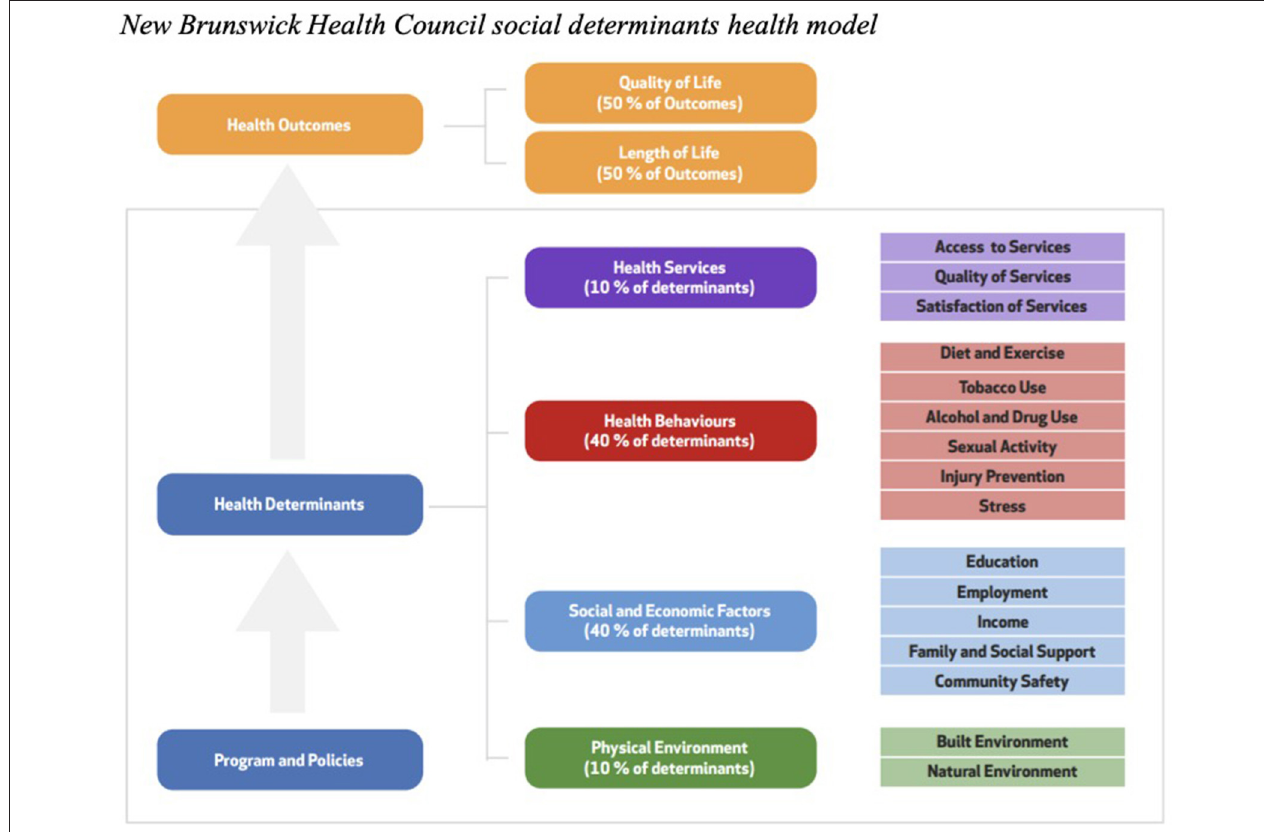
FIGURE 1 | New Brunswick health council social determinants health